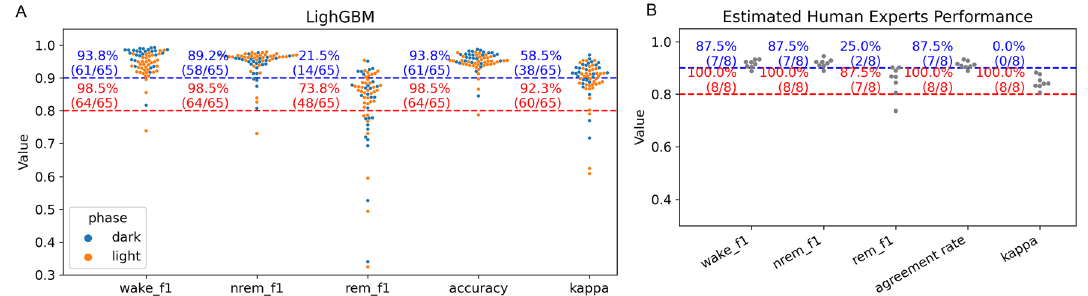
Figure 5. Comparisons of the recording-level performances between the LightGBM model and human experts. ( A ) The performance of the LightGBM model was evaluated individually in 65 recordings. Recordings from the dark cycle are shown in blue; recordings from the light cycle are shown in orange. ( B ) The scores of two human experts from a publicly available dataset were compared to each other across 8 recordings. Blue text indicates the percentage of recordings above the threshold of 0.9, indicated by the blue dashed lines. Red text indicates the percentage of recordings above the threshold of 0.8, indicated by the red dashed lines.